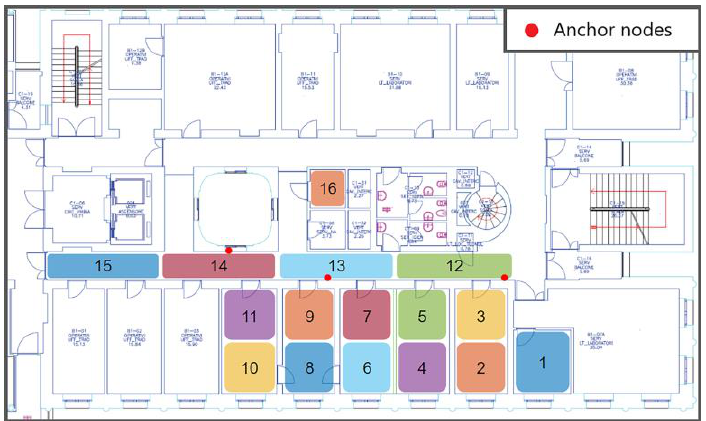
Figure 6. Test site map. The sixteen areas for the second experiment are highlighted. The red dots represent the anchor nodes.